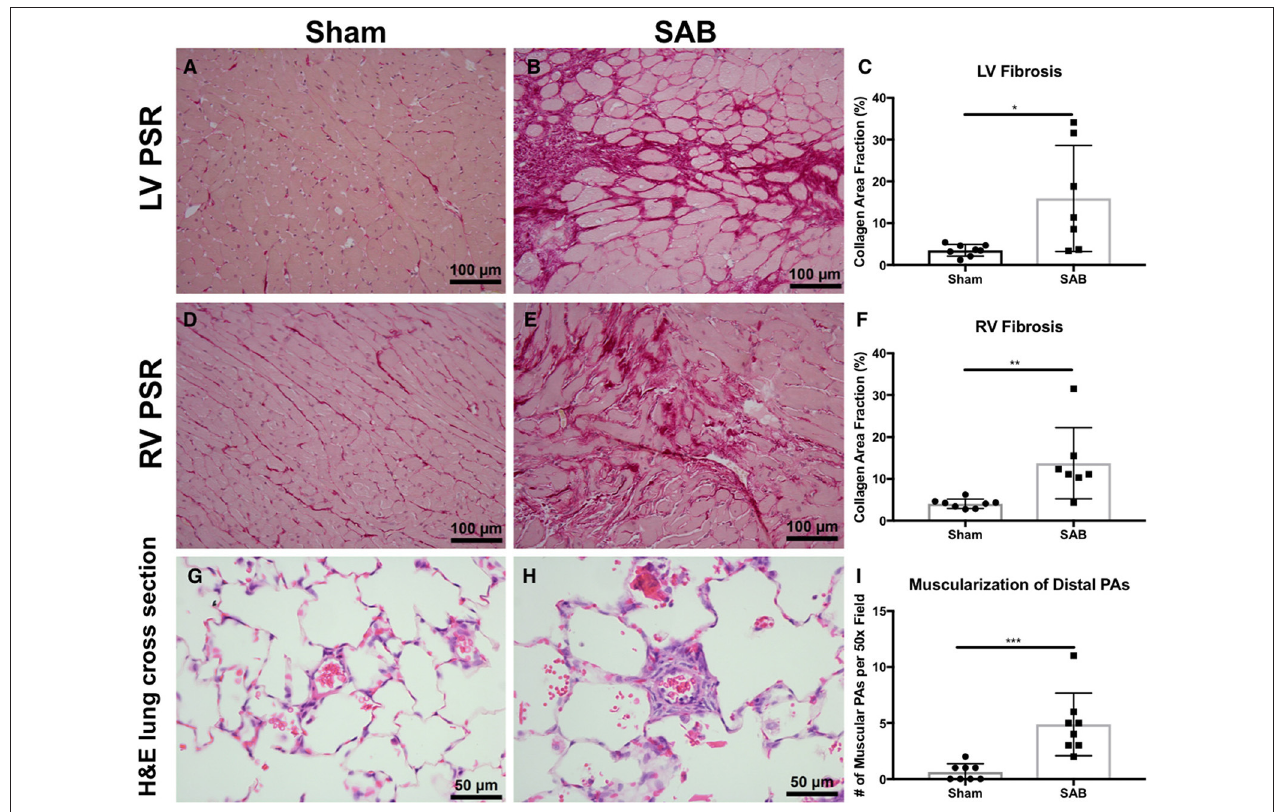
FIGURE 3 | Histology and confocal microscopy images of sham vs. supra-coronary aortic banding (SAB) rats. Picrosirius red (PSR) staining of left ventricle (LV), and right ventricle (RV) of (A,D) sham vs. (B,E) SAB rats showing (C,F) increased myocardial fibrosis in SAB rat. Hematoxylin and eosin (H,E) stain of lung cross section of